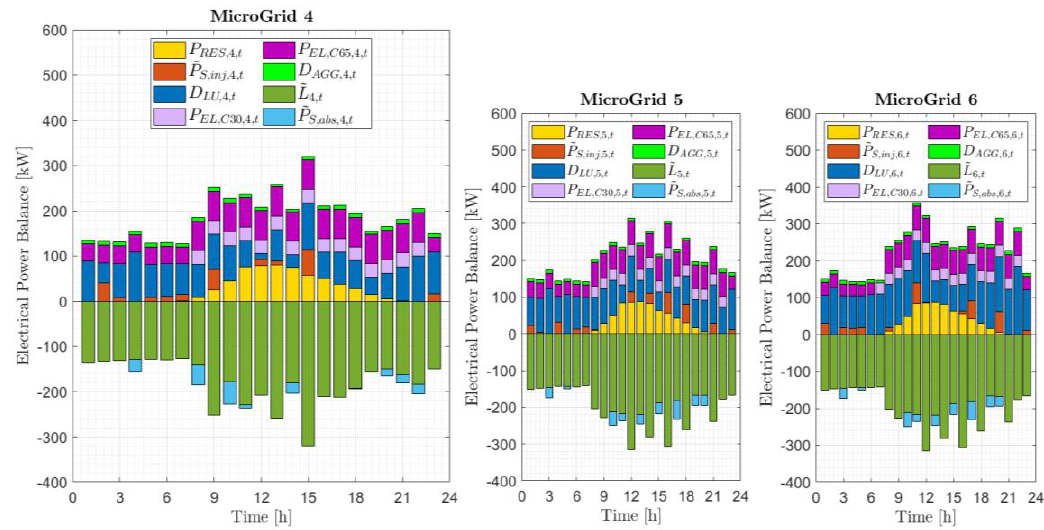
Figure 13. Electrical balance in the LUs (microgrids).